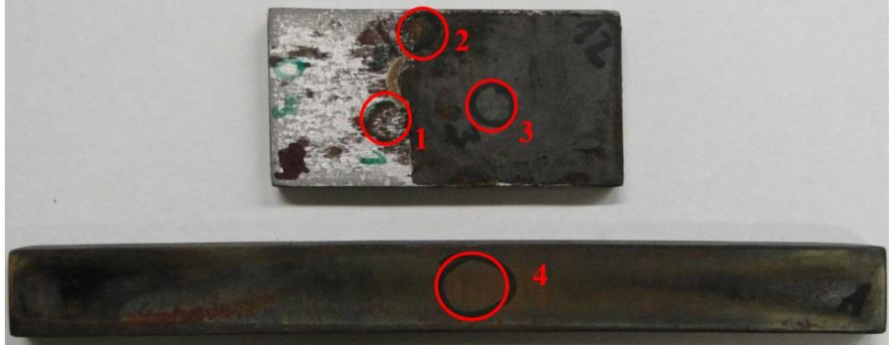
Figure 11. Macrostructure of the corroded sample at 65 ◦